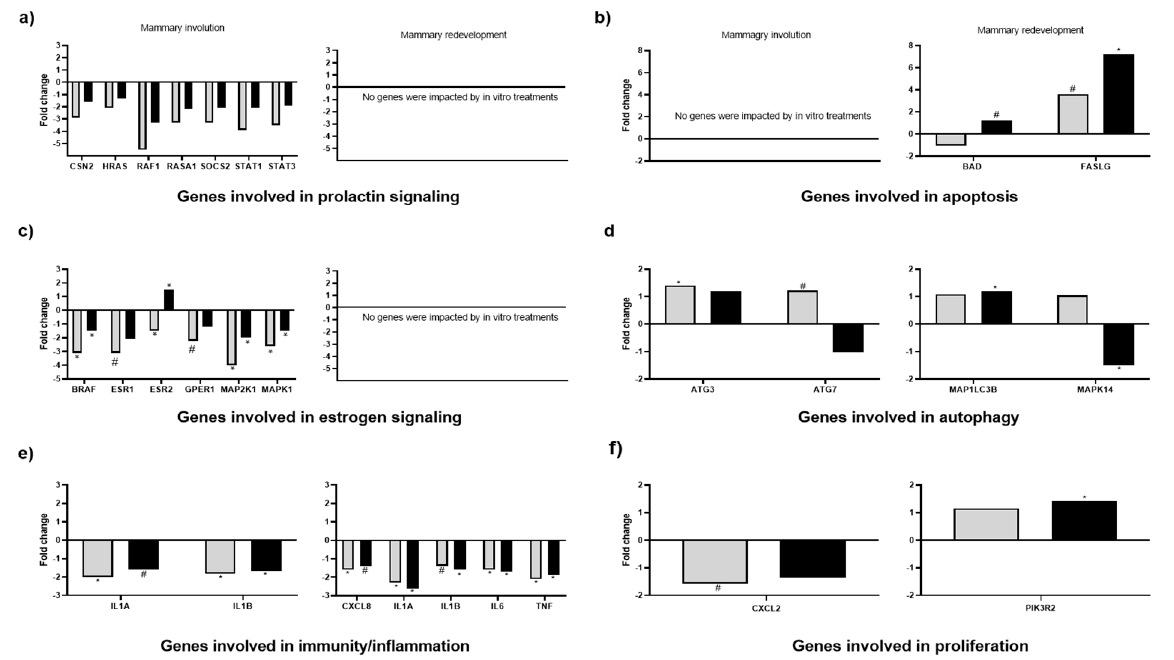
Figure 5. Expression of genes involved in Prolactin (PRL) and oestrogen (E) signalling, cell apoptosis in tissue explants of mammary gland incubated in 3 different media: (1) Basal (B): no PRL or E; (2) Cooled-mimic (C): B + 20 ng/mL PRL + 5.8 ng/mL E or (3) Heat stress-mimic (H): B + 40 ng/mL PRL + 2.9 ng/mL E. Explants were collected during early involution (3 d after dry off) and during mammary growth phases (35 d after dry off). Gene expression in mammary gland tissue explants is reported as fold change (2 - ∆∆ Ct ) relative to B media. Grey bars indicate C fold change and black bars indicate H fold change. An asterisk (*) indicates significant differences ( p ≤ 0.05) and (#) indicates tendencies (0.05 < p ≤ 0.15) between C (light grey bars) and B and HT (solid black bars) and B media. ( a – f ) refer to gene